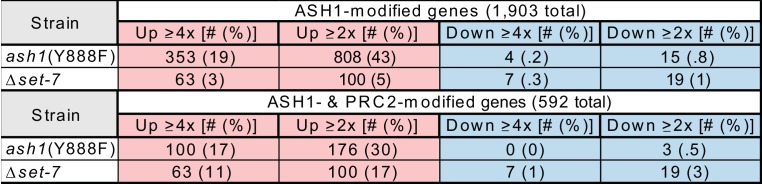
Gene expression changes are summarized for genes marked by ASH1-catalyzed H3K36me2 (Top) and genes comarked by ASH1-catalyzed H3K36me2 and SET-7-catalyzed H3K27me2/3 (Bottom) in the ash1(Y888F) and Δset-7 strains.Results for Δset-7 are derived from Klocko et al., 2016.10.7554/eLife.41497.012Figure 5—figure supplement 2—Source data 1 .Gene expression changes (log2 ash1(Y888F)/wt).